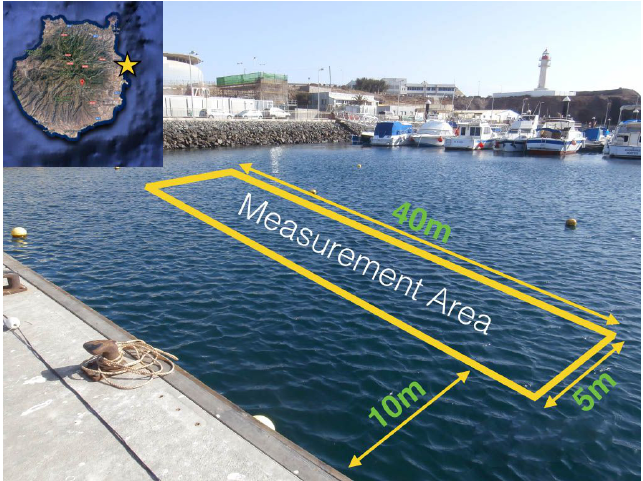
Figure 1. Measurement area in Taliarte’s